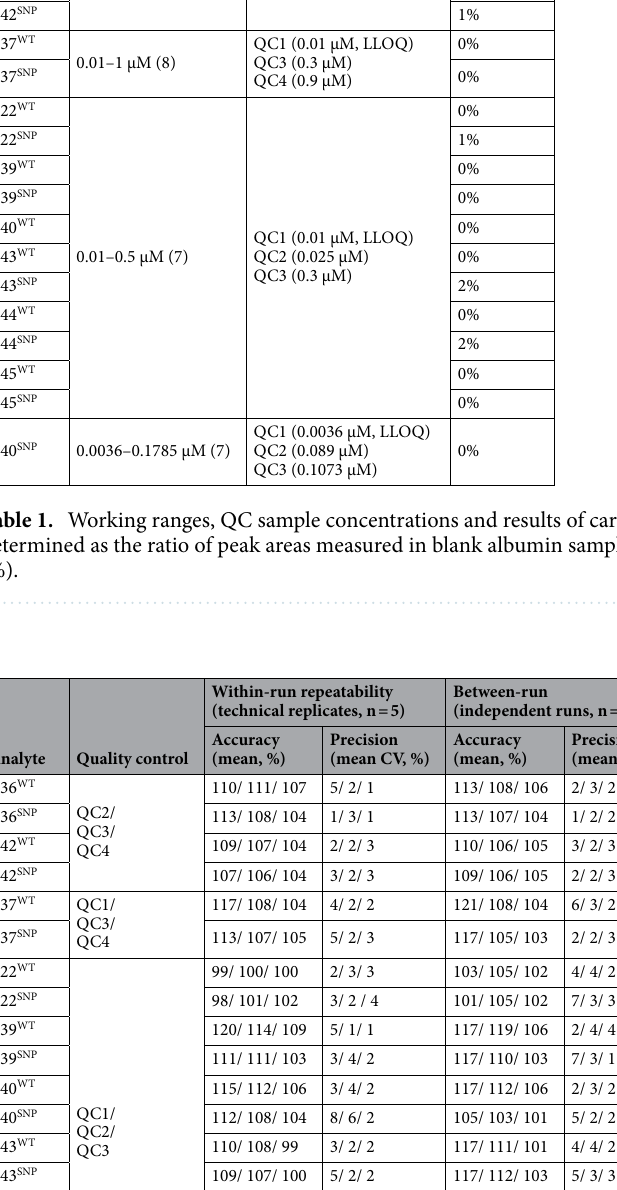
Table 2. Accuracy and precision of repeated measurements.